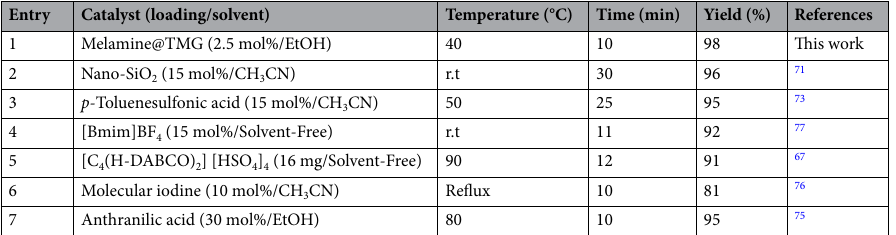
Table 3. Comparison of the catalytic activity of nano-ordered Melamine@TMG organocatalyst ( 1 ) versus some introduced catalysts for the synthesis of 5a